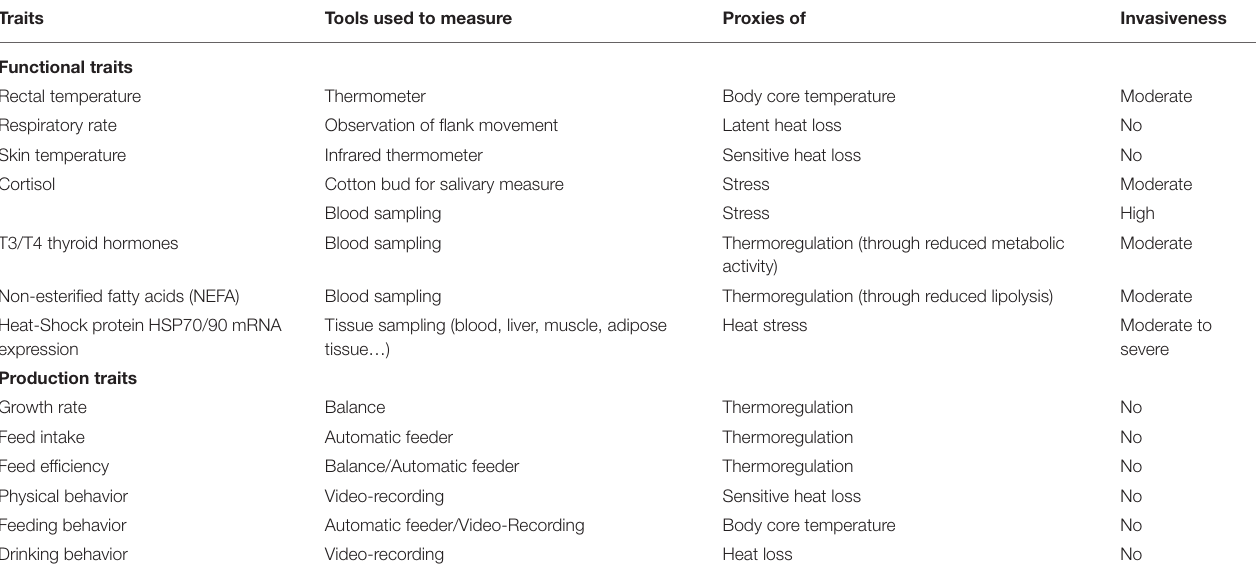
TABLE 1 | List of traits associated to thermoregulation use in pig studies.